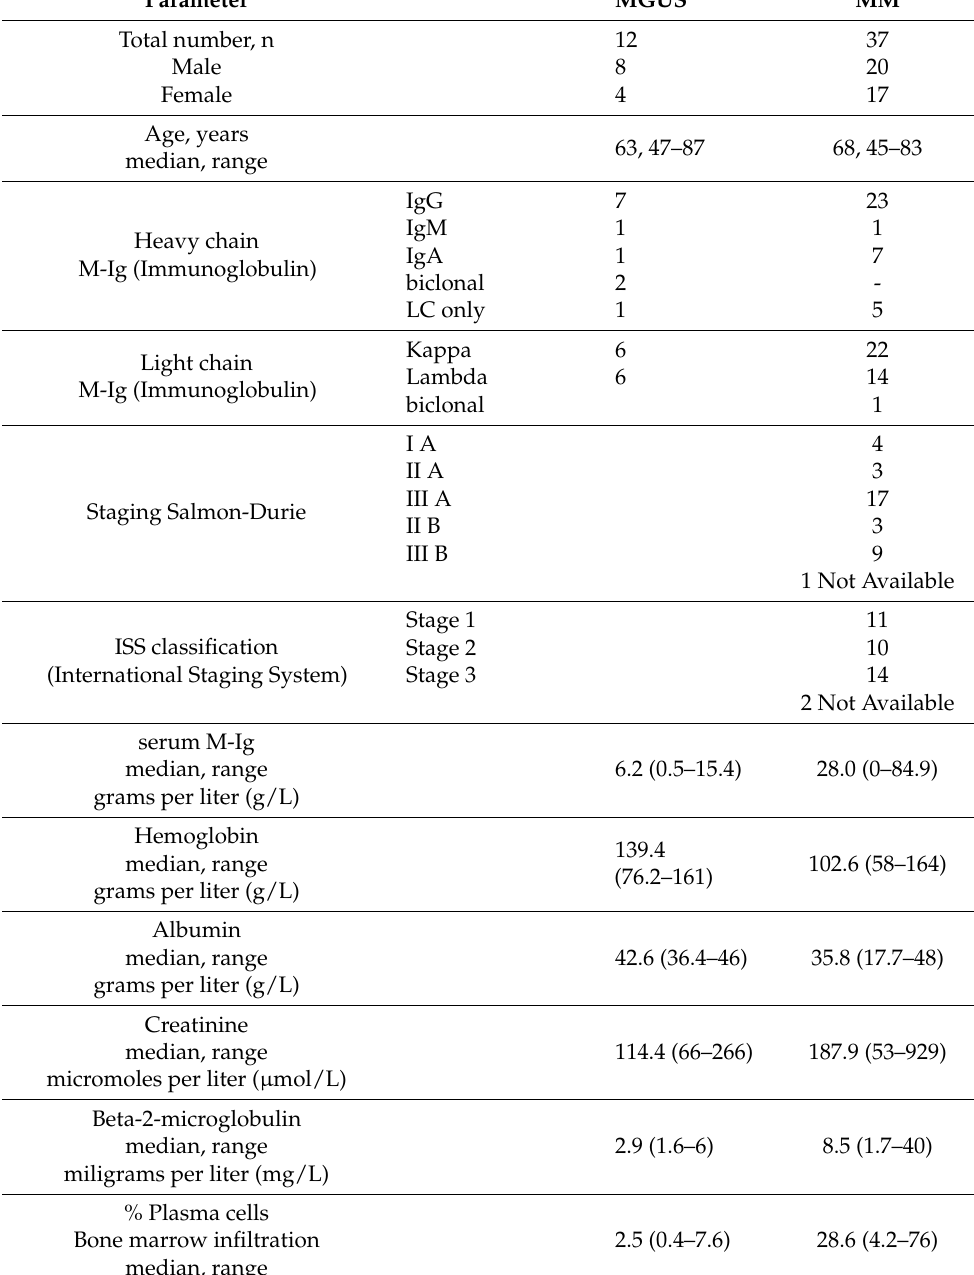
Table 1. Summary of patient